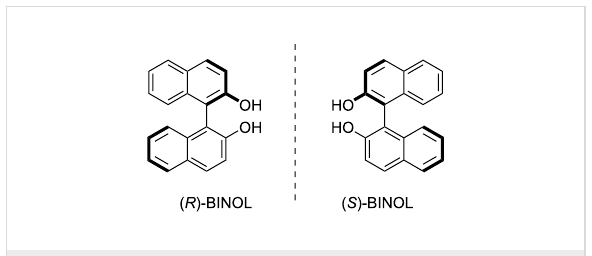
Figure 1: Molecular structures of ( R )-BINOL (left) and ( S )-BINOL